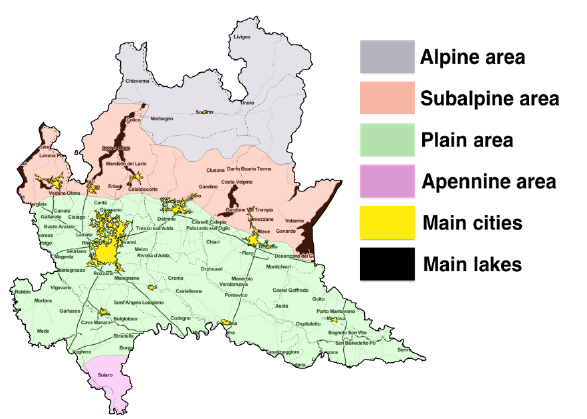
Figure 1. Schematic reference map including the main territorial features of Lombardy Region. (Map tiles by Stamen Design, under CC BY 3.0. Data by OpenStreetMap, under CC BY